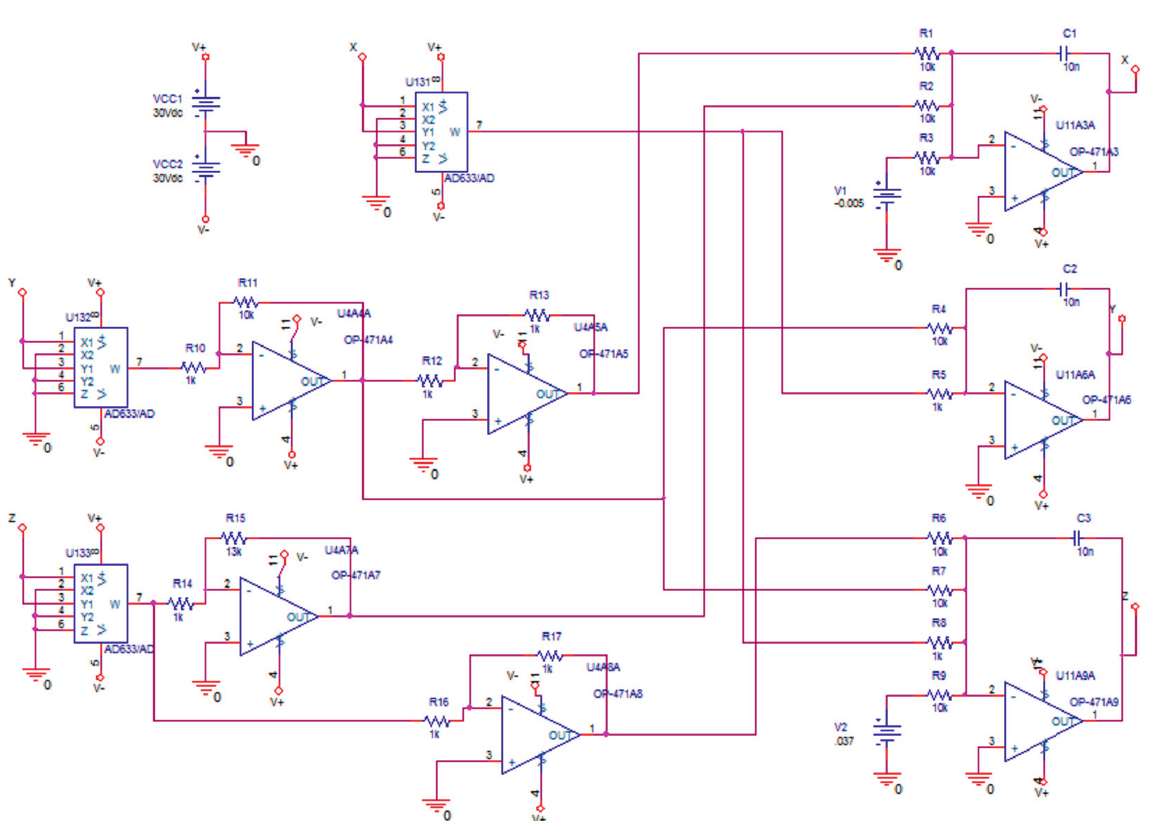
Figure 5: Schematic of the pure nonlinear system’s designed circuit. In the designed circuits, all used elements are analogs. Op-Amps are used as integrators. Besides, they are also used for regulating the coefficients of nonlinear terms. Capacitors and resistors are the other analog elements in the circuit. The circuit is simulated in PSpice